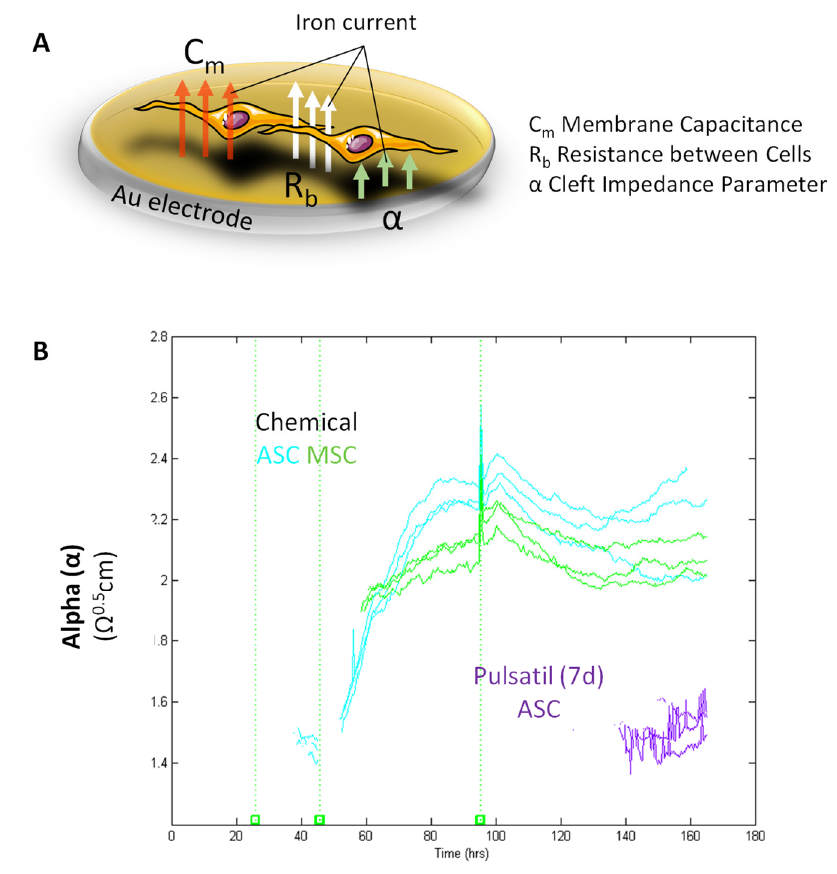
Figure 5. Impedance Modeling. ( A ) Schematic illustration presenting the modeled parameters R b , α , and C m . R b describes the paracellular barrier between cells caused by tight cell-to-cell junctions; α models the basal adhesion, indicating the cell-to-substrate interaction; C m shows the cell membrane capacitance. Notably, α is dependent on the cell radius and the subcellular adhesion. Adapted by Giaver and Keese [4]. Created with www.biorender.com. ( B ) Calculation of the cell-to-substrate interactions ( α ) in chemical osteogenic and electrically stimulated stem cells from the adipose origin (ASC) and bone marrow (BMSC). The equation for calculating α is given in the right corner: r c = cell radius, p = specific electrolyte resistivity in the cleft, and h = distance between membrane and electrode. Notably, the higher the distance (h) from cells to substrate, the smaller α . Chemical osteogenic stimulated ASCs and BMSCs revealed a continuous increase in α over time. Pulsatile electrical stimulation of ACSs also showed a rise in α starting at 140 h. During seven days, no alterations in α were observed for POBs, control-treated, and electrically continuously stimulated stem cells (n = 3–5).